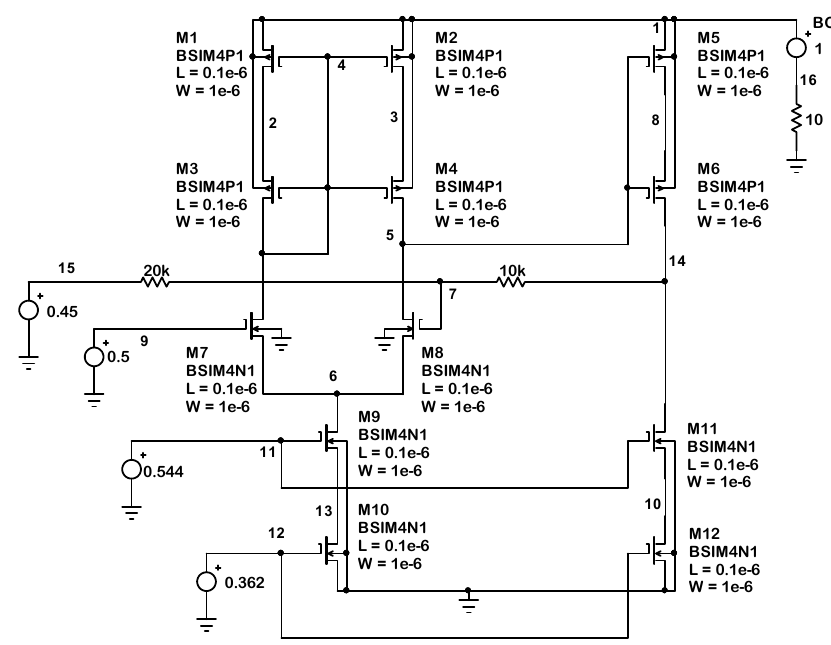
Figure 8. CMOS circuit with transistors represented by the BSIM4.6 model and DC solutions found by the proposed